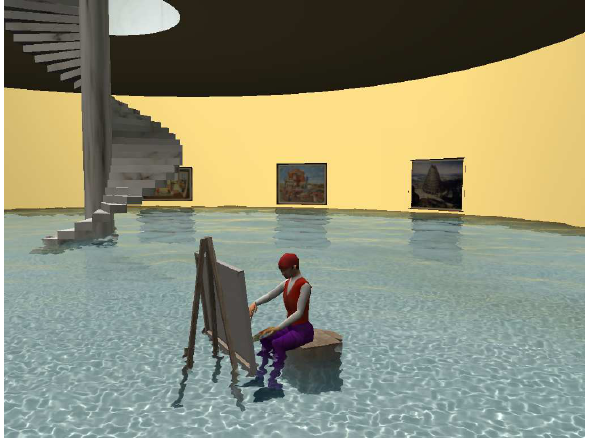
Fig. 5 Interior of the tower, something that is not visible in the original